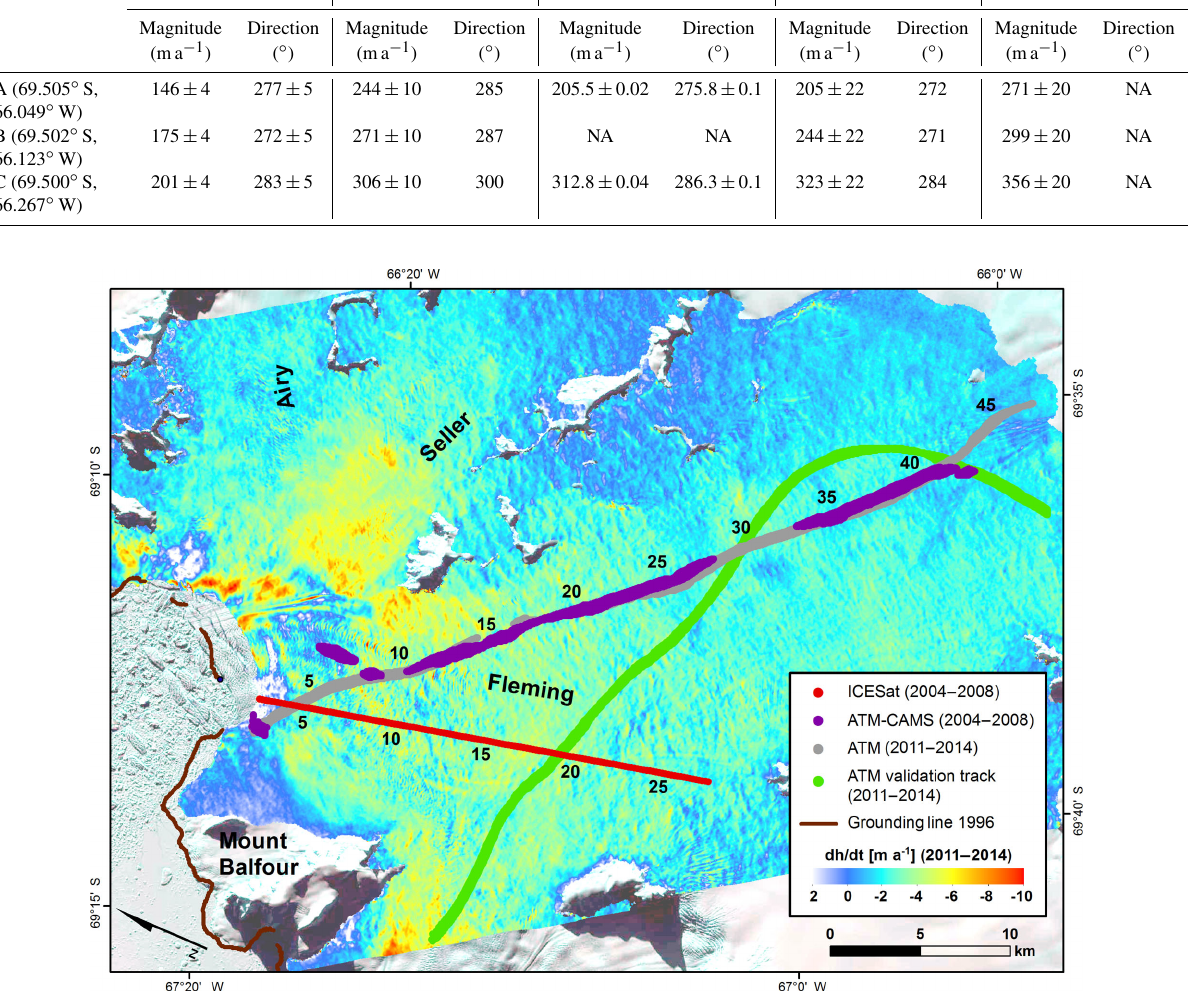
Figure 4. Glacier surface elevation change on Fleming Glacier between 2011 and 2014 derived from TSX-TDX bistatic and monostatic acquisitions. Red dots: ICESat track on 4 October 2008 taken as reference for ICESat 2004–2008 d h/ d t calculations. Purple dots: common locations of PIB ATM and CAMS lidar measurements in 2004 and 2008. Grey dots: common locations of OIB ATM lidar measurements in 2011 and 2014. Green dots: common locations of OIB ATM lidar measurements in 2011 and 2014 taken for validation of the 2011–2014 TSX–TDX d h/ d t measurements. Brown line: grounding line in 1996 from Rignot et al. (2005, 2011a). Numbers indicate distances to the 1996 grounding line. Background: mosaic of two Landsat-8 “Natural Colour” images, acquired on 16 September 2015,